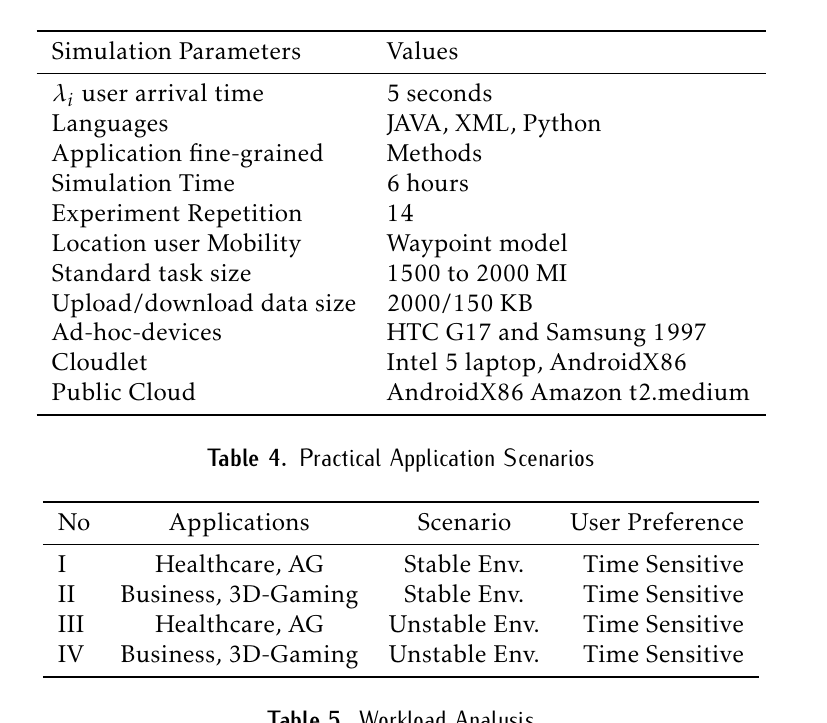
Table 3. Simulation Parameters